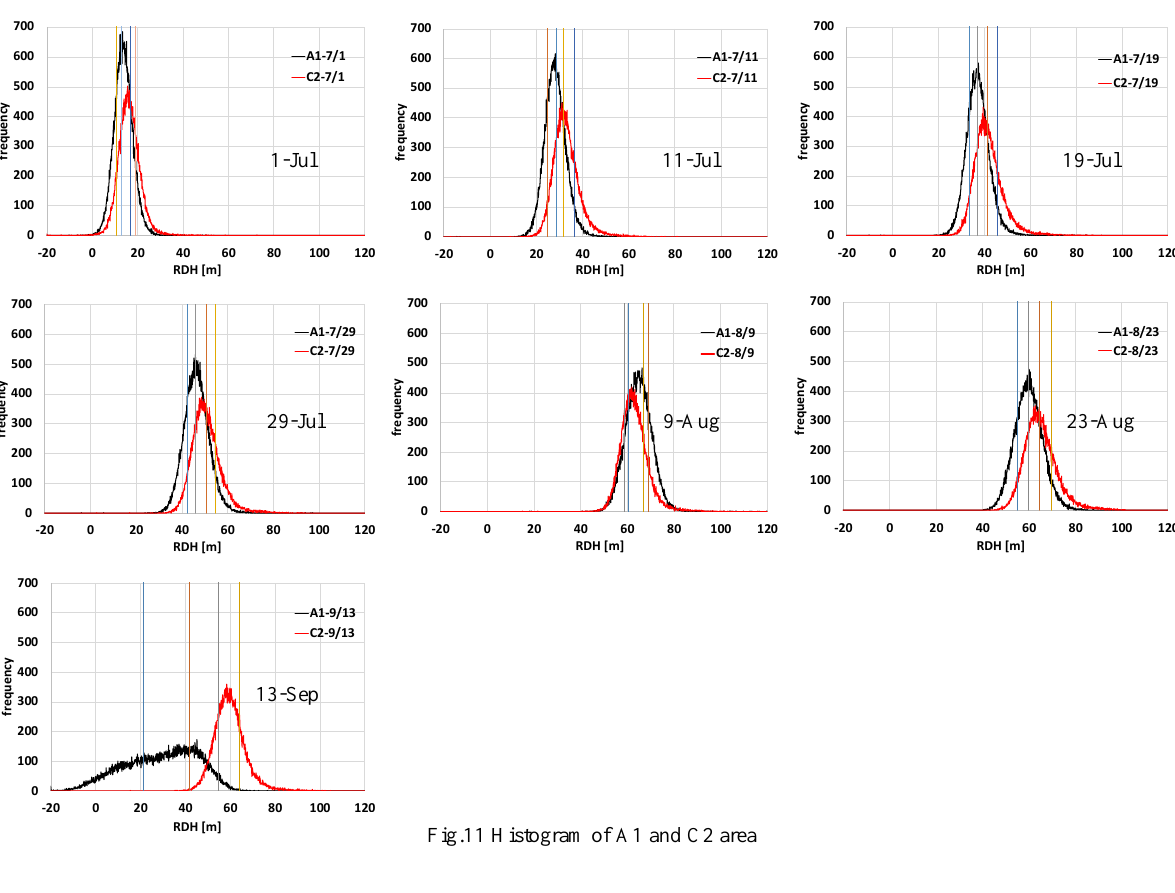
Fig.11 Histogram of A1 and C2